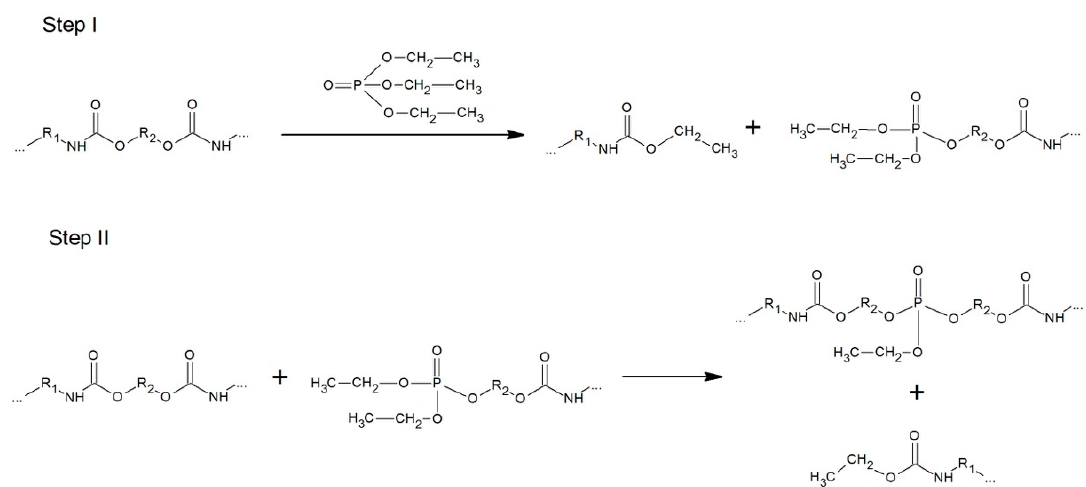
Figure 6. Polyurethane phosphorolysis.